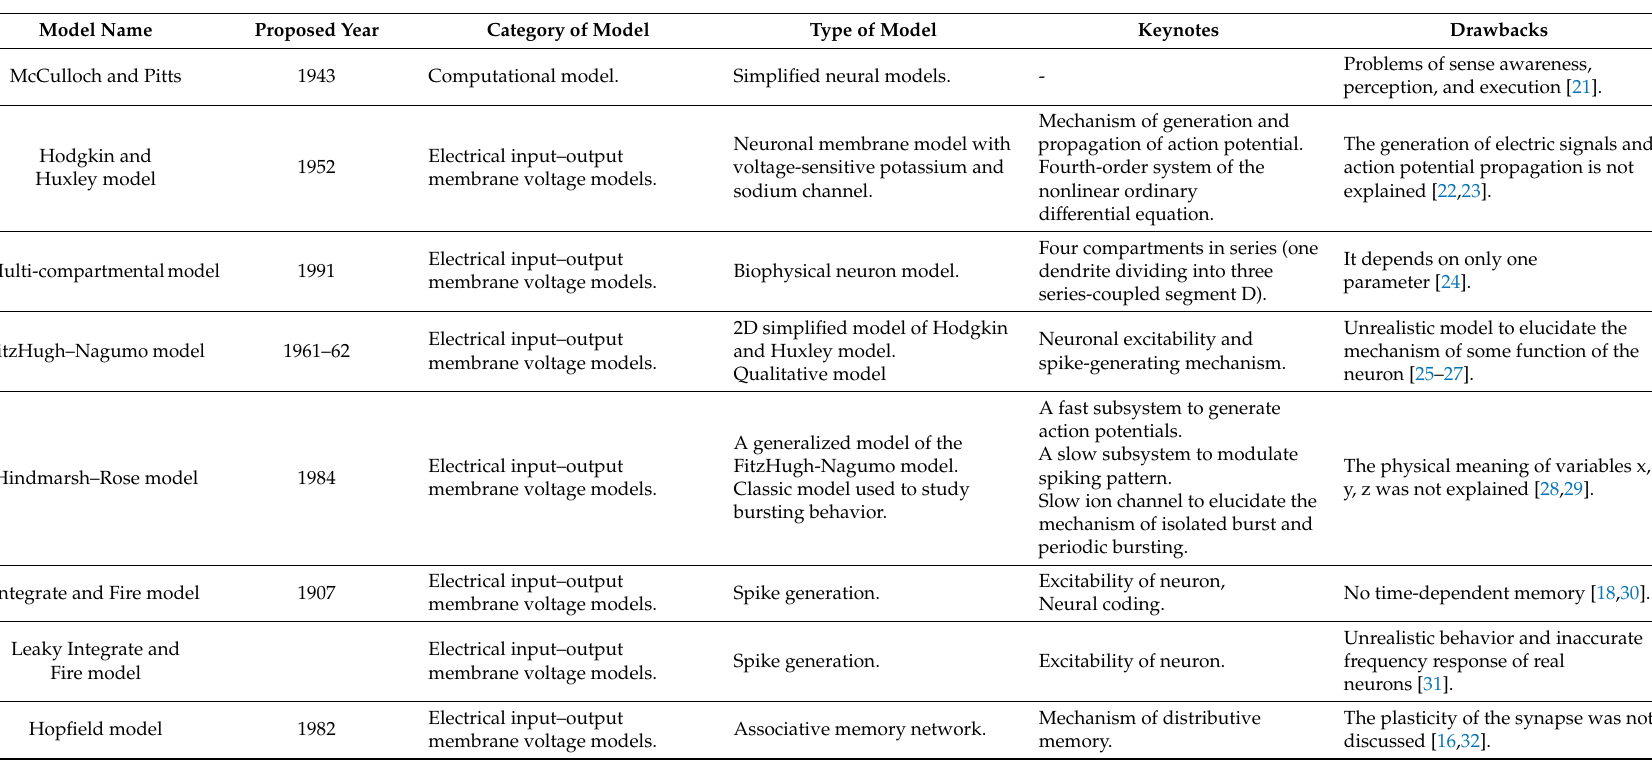
Table 1. Single-neuron models, including the year of model proposal, model category, type of model, keynotes, and